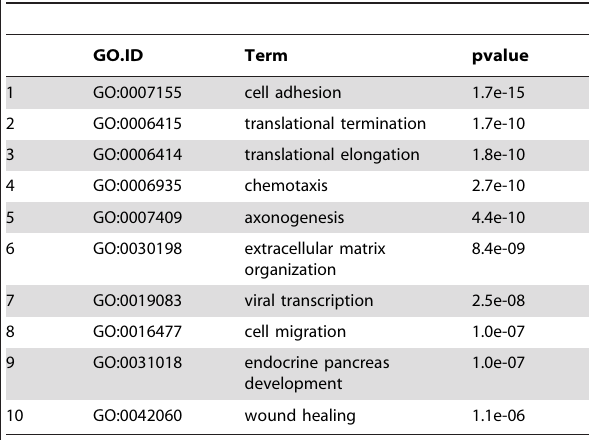
Table 7. Gene Ontology (GO)